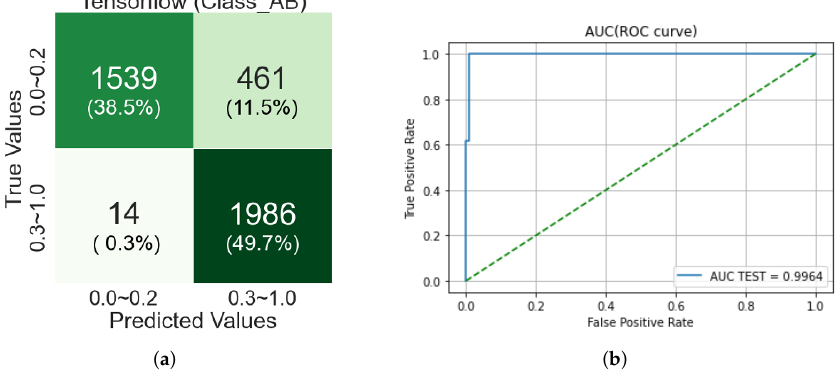
Figure 14. Verification results of 4-Class VA Classifier. ( a ) Confusion matrix; ( b ) Classification report.